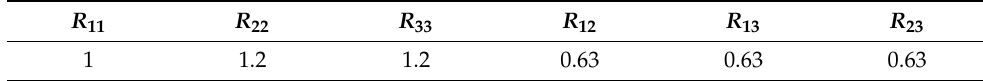
Table 1. Yield stress ratios of KDP